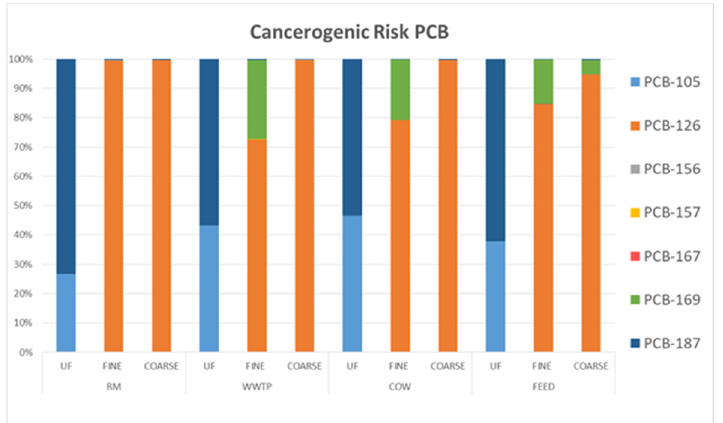
Figure 12. Percentage distribution of carcinogenic risk of each single compound in ultrafine, fine and coarse fraction of PM in the four sampling sites.